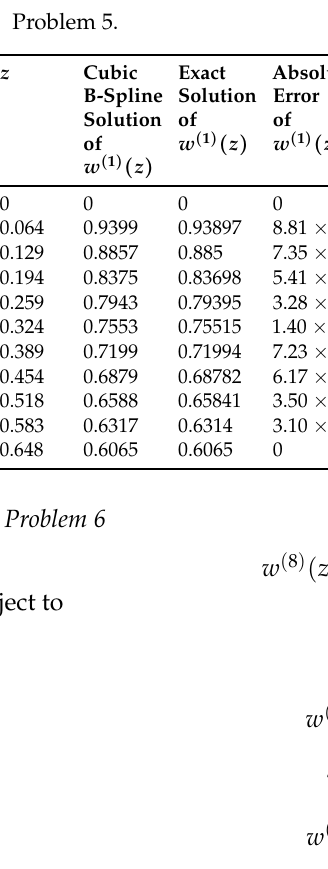
where boundary conditions are defined in 10